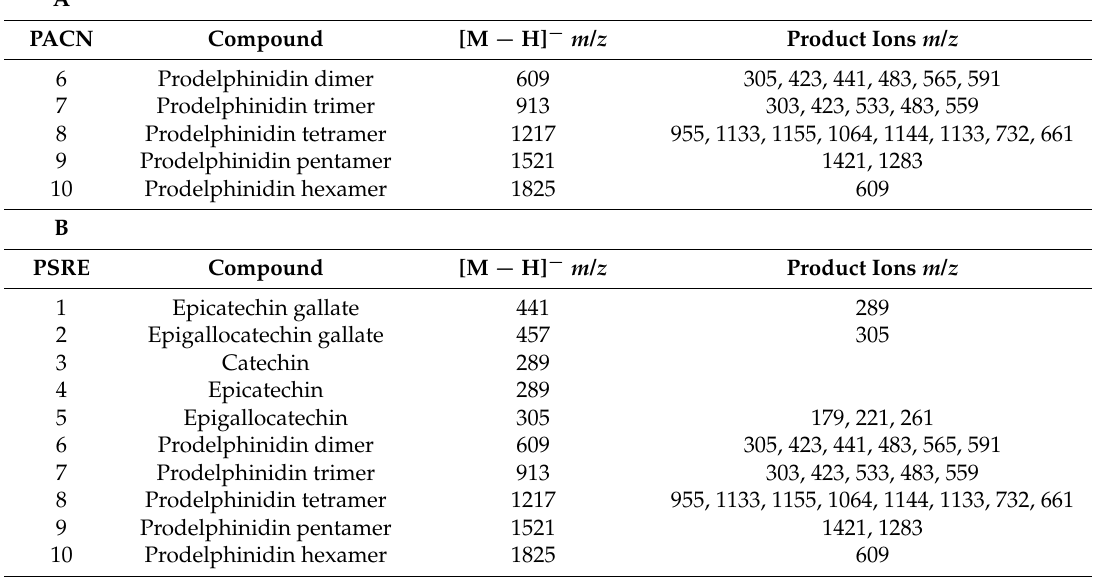
Table 1. List of phenolic compounds identified in proanthocyanidins (PACN) fraction (A) and Pelargonium sidoides root extract (PSRE) methanol fraction